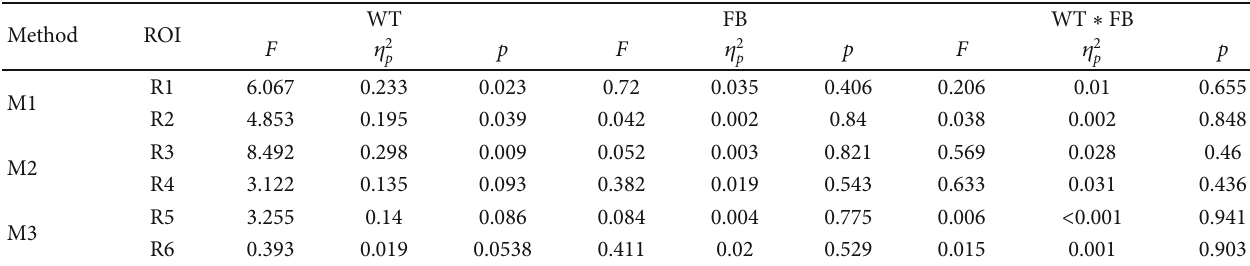
Table 1: The statistical results of N2-theta oscillation for the conventional time-frequency analysis ( “ M1 ” ), the proposed approach ( “ M2 ” ), and TFA-PCA ( “ M3 ” ).